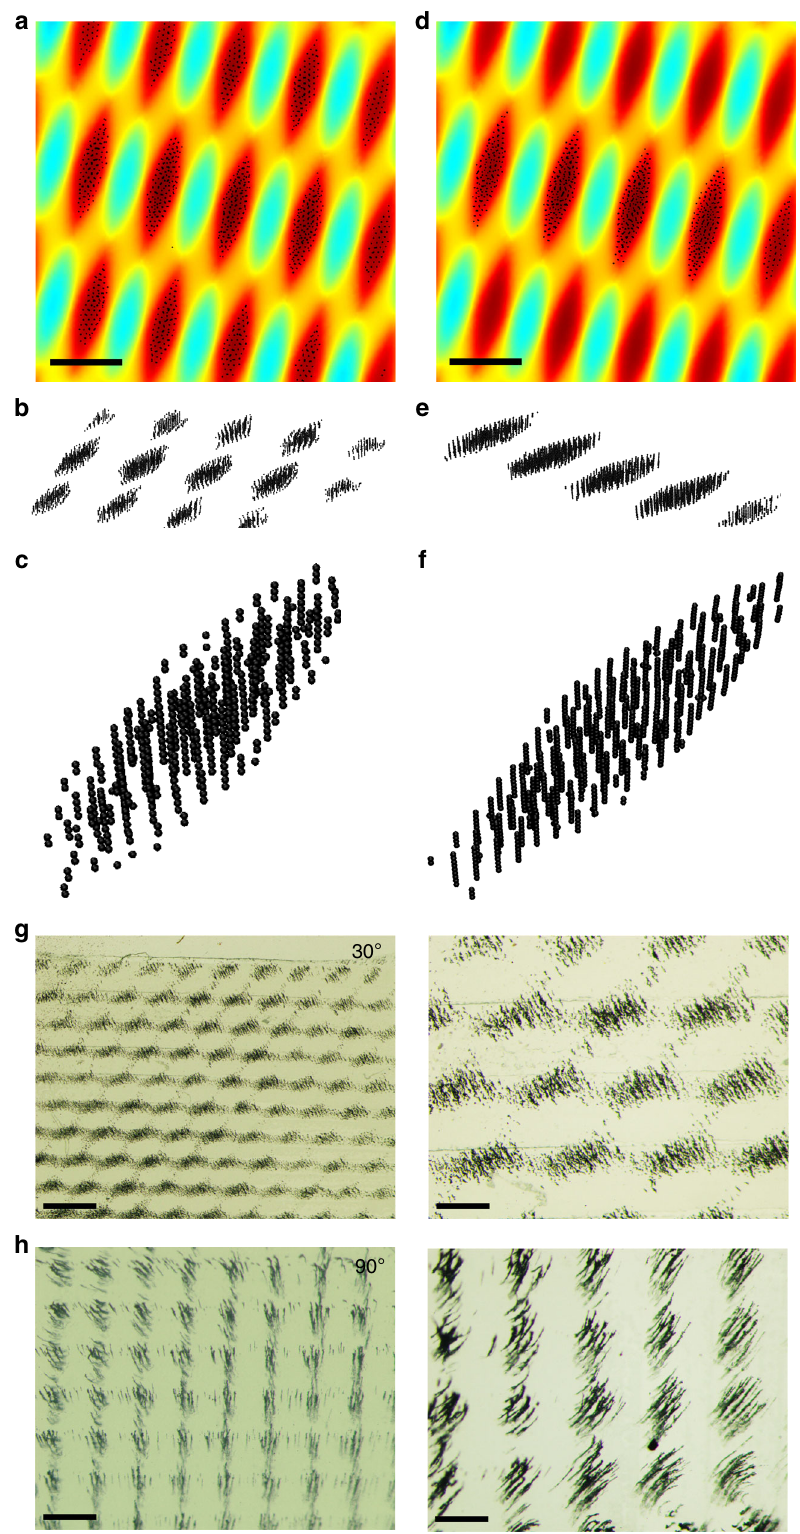
Fig. 5 3D moiré-like magnetic patterns in simulations and in experiment. The simulations were performed for two stamps of parallel line features and a – c “ statically ” placed at θ = 30 o on top of one another, and d – f “ dynamically ” rotated (in discrete steps of 2 o per 2 ms) from θ = 0 o to 30 o . In both cases, the particles form discrete chains, as emphasized by perspective/inclined views in b , c , e , f . Number of particles in each simulation was 5000. Scale bars = 50 µ m. See also Supplementary Movies 5 and 6. g , h Optical micrographs of patterns in which Fe microparticles form discrete vertical chains over the regions of fi eld maxima. Two patterns of 200- μ m-wide, parallel magnetic lines were placed at angles g , θ = 30 o and h , θ = 90 o . Scale bars are 500 μ m for the images in the left column and 200 μ m for the images in the right